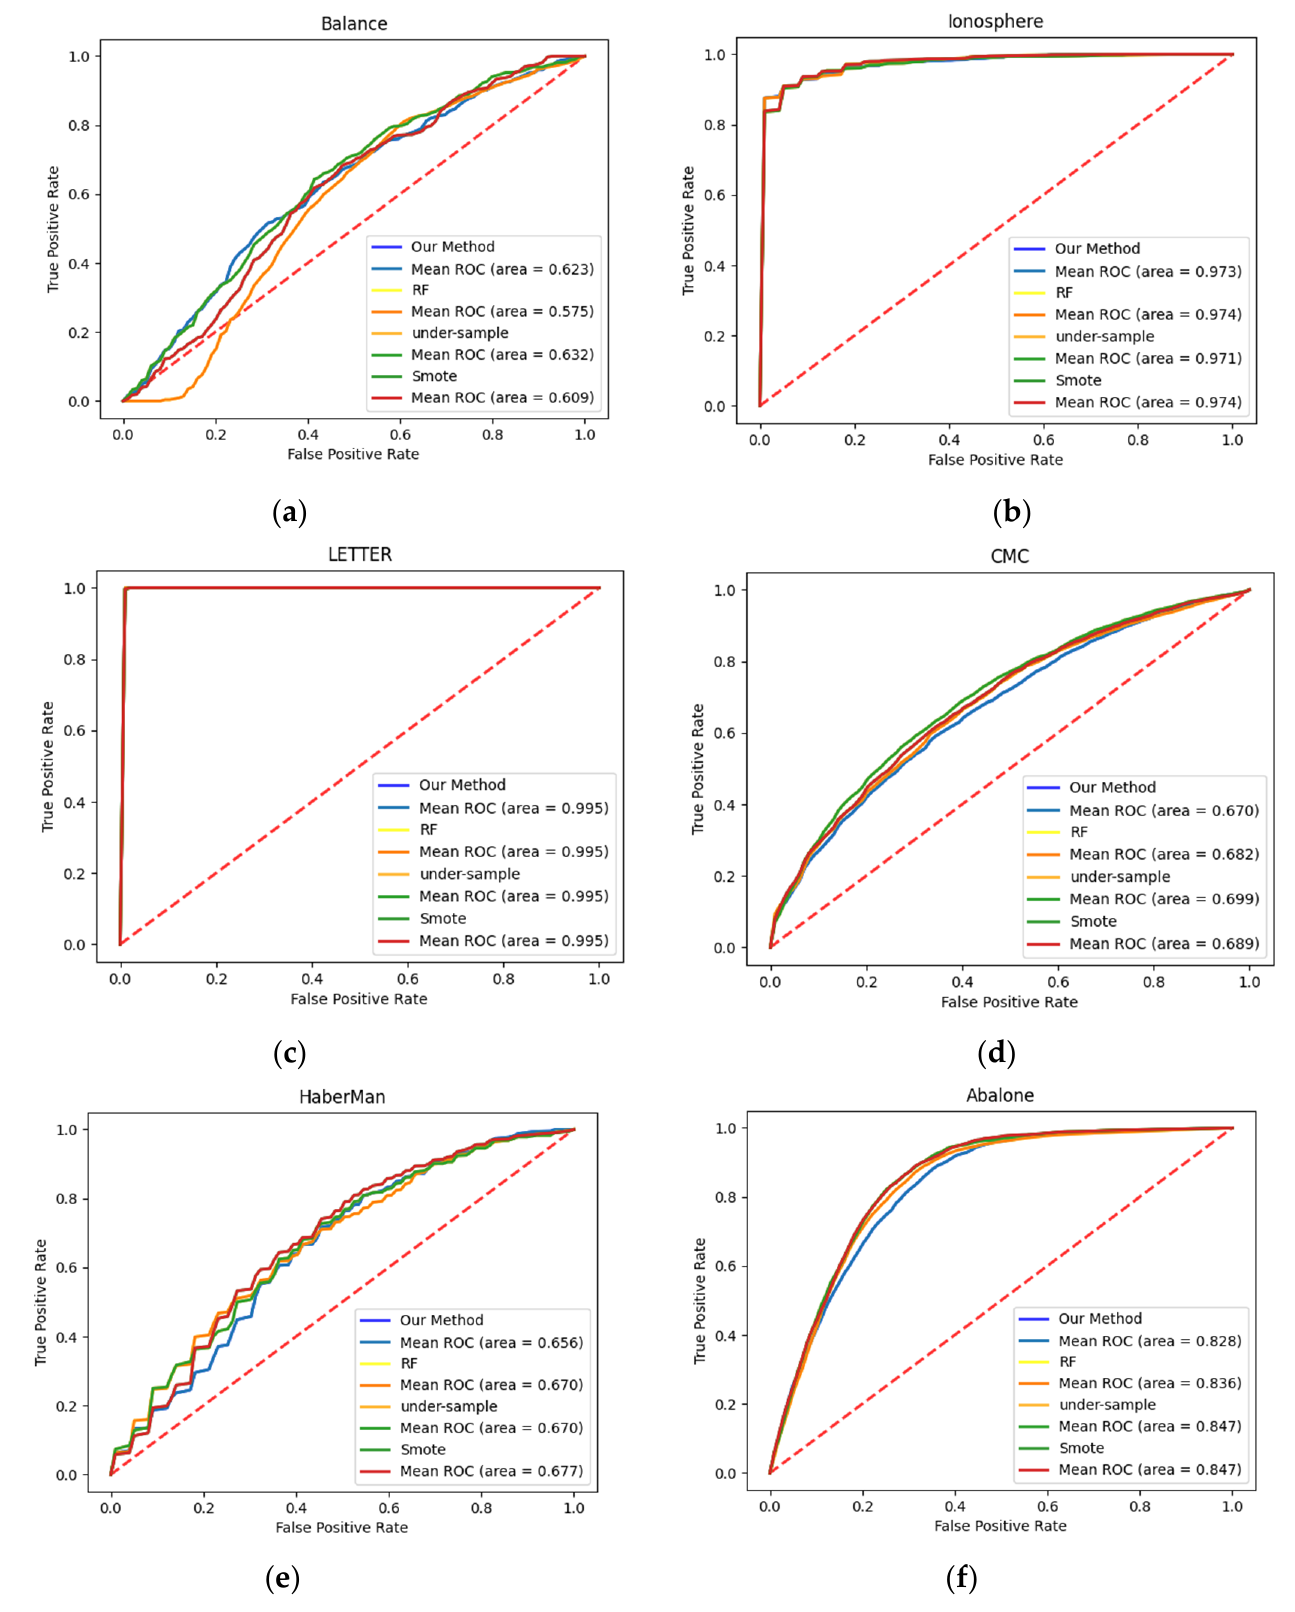
Figure 4. The average AUC scores of four examined methods.